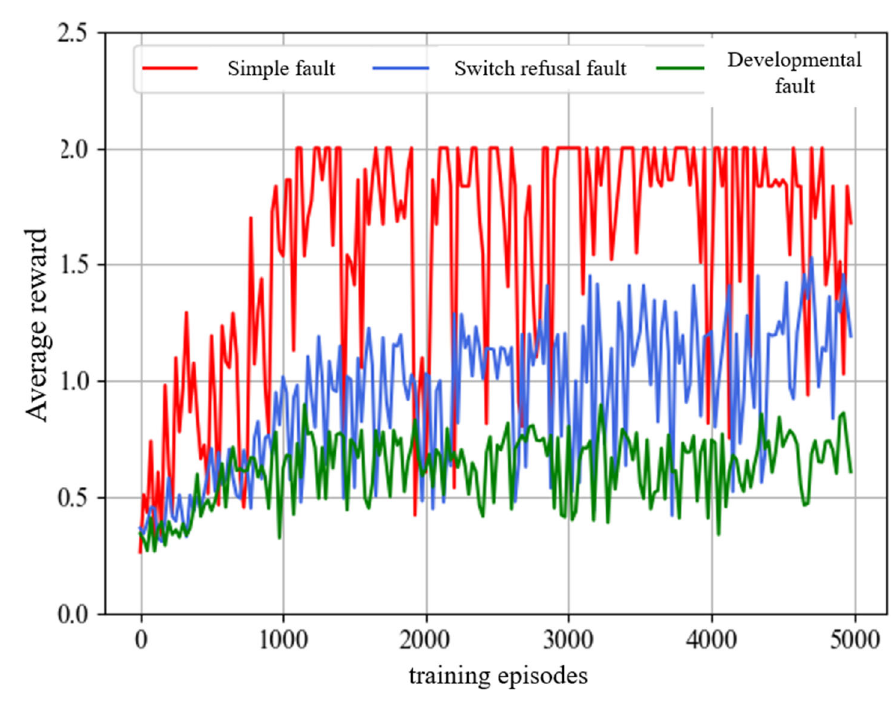
Figure 6. Average reward.